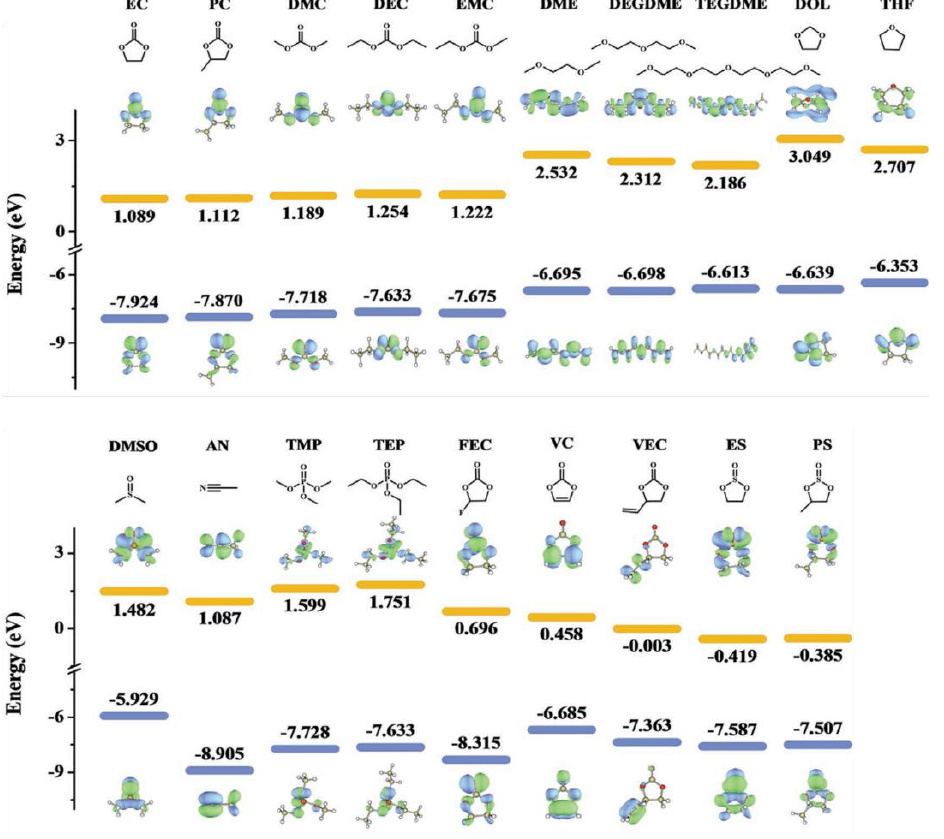
Figure 2. Molecular structures, LUMO (up), and HOMO (down) of state − of − the − art solvents and additives for PIBs. Reprinted with permission from Ref. [6]. Copyright 2021, John Wiley & Sons. Table 2. Summary of oxidation limits for normal-concentrated potassium-based electrolytes with different